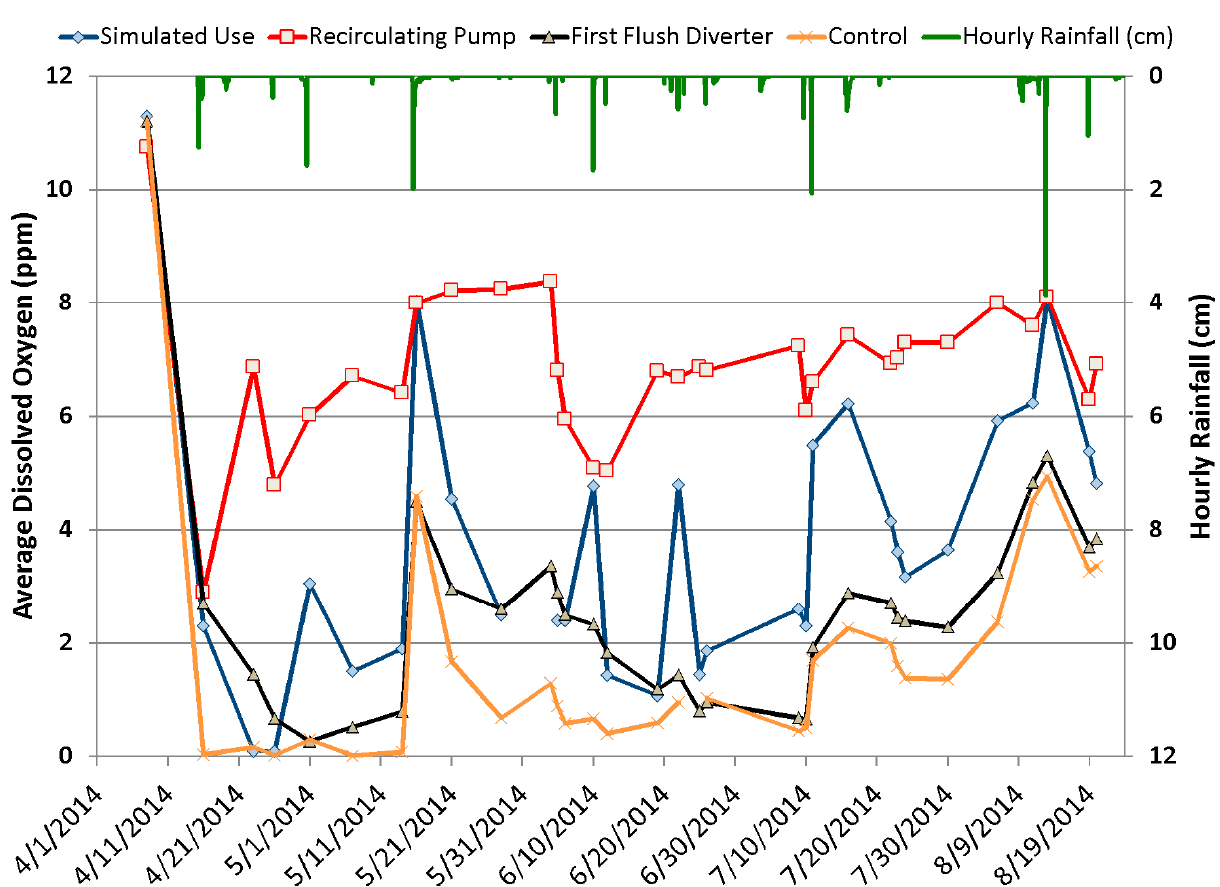
Figure 4. Average DO concentrations within each tank as compared to rainfall observed at the study site.